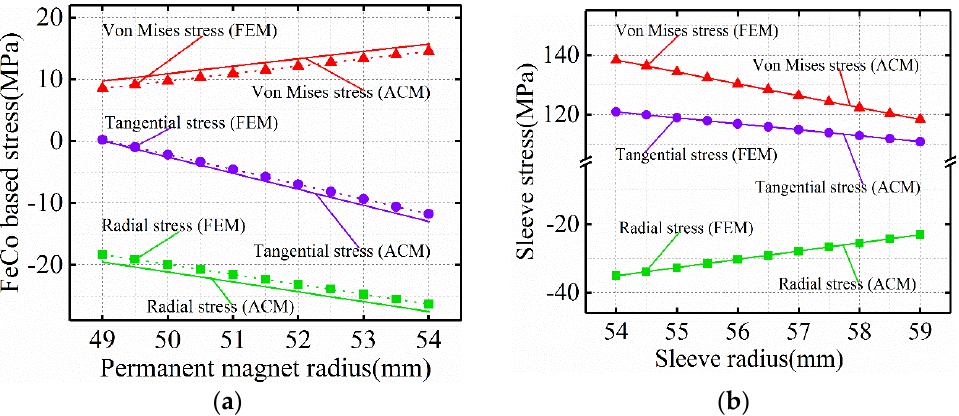
Figure 9. Stress distribution of ( a ) FeCo-based PM and ( b ) sleeve under cold rotating condition.